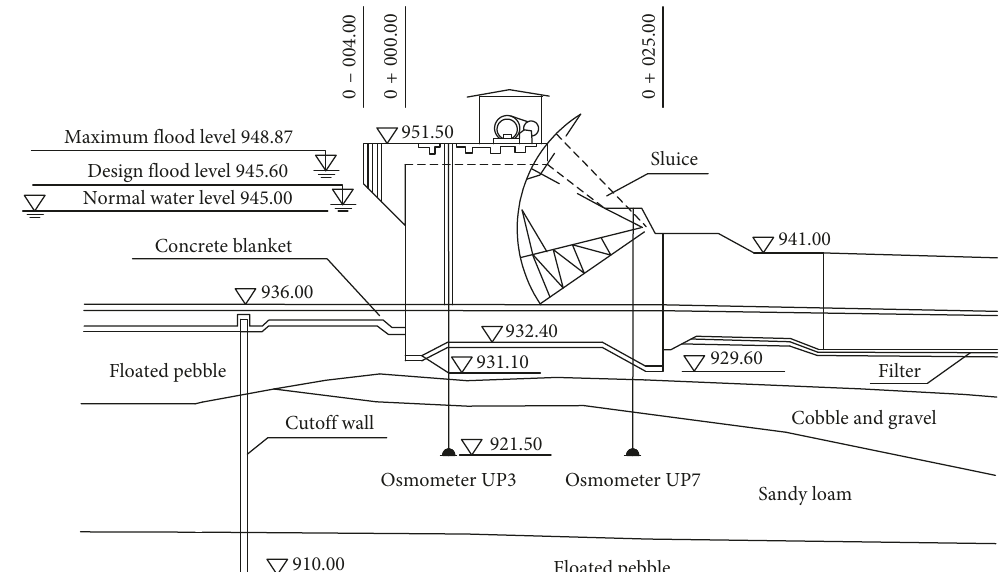
Figure 3: Cross section for 2# sluice foundation.